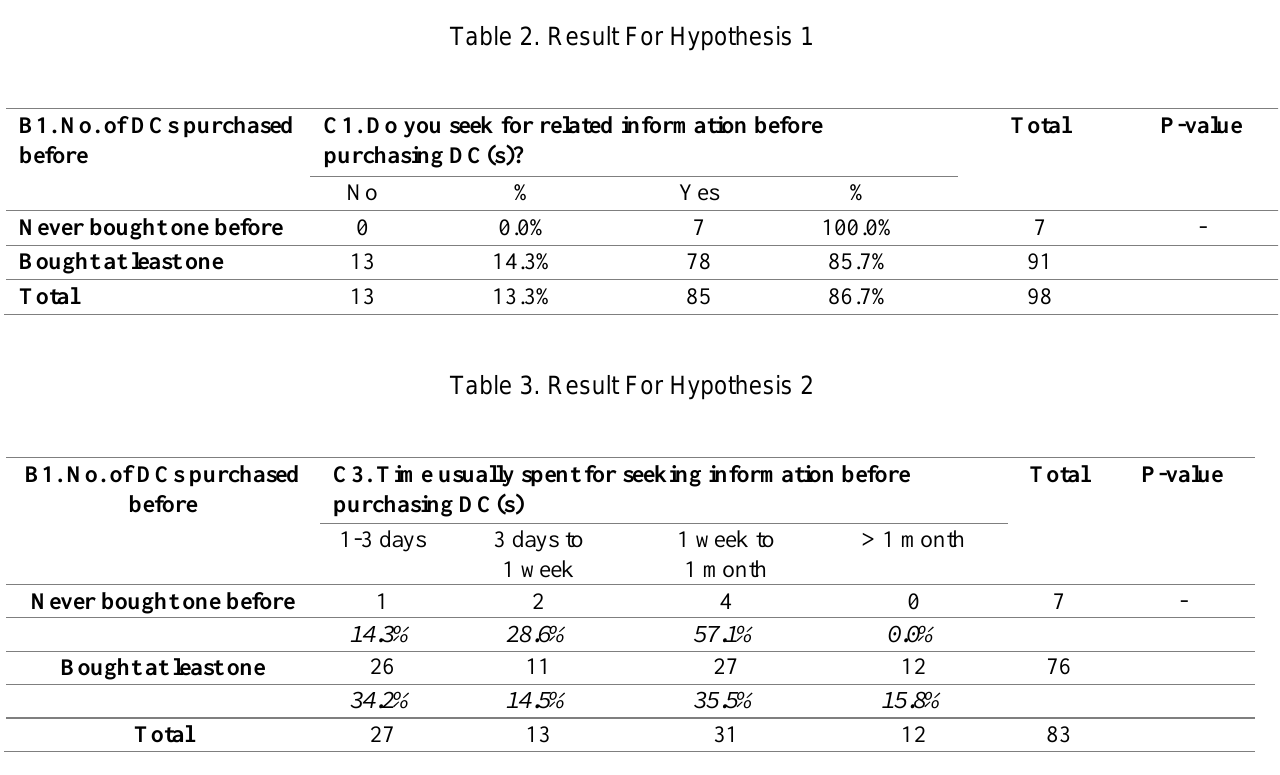
Table 4. Result For Hypothesis